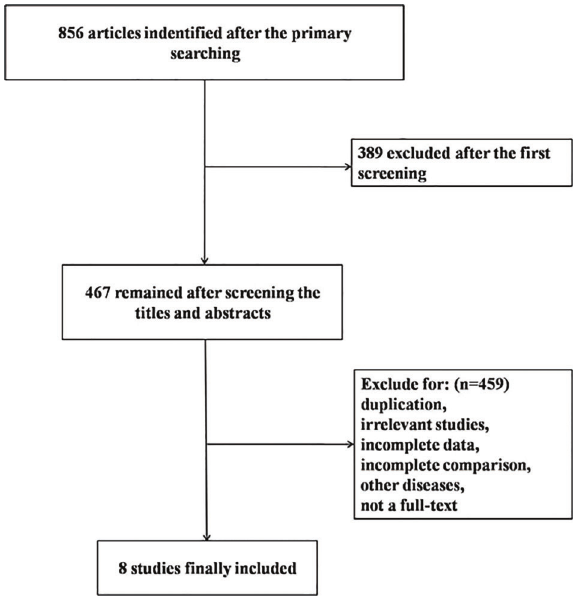
Figure 1. Flow diagram of the study selection process and the reasons for Table 1. Characteristics of the included studies.